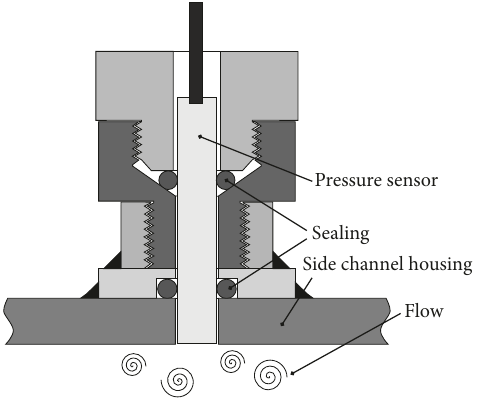
Figure 6: Wall pressure sensor mount.